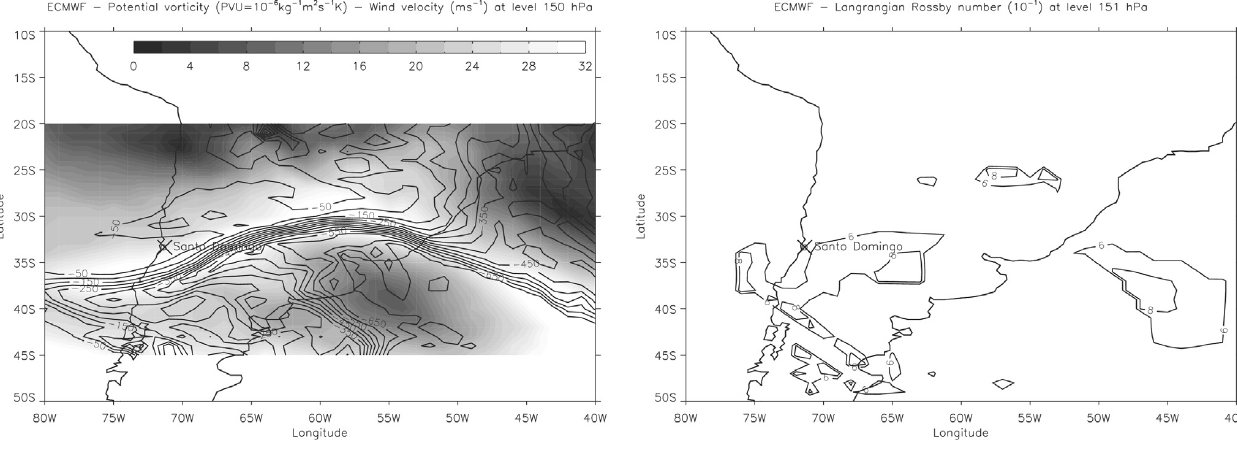
Fig. 4. Case 1: Results of the ECMWF reanalysis at the 150 hPa level (altitude ∼ 11.6km). The Santo Domingo location is marked by the cross. Left: Contours: potential vorticity field (in PVU, 1PVU = 10 − 6 Km 2 kg − 1 s − 1 ). Levels of grey: wind velocity (in ms − 1 ). Right: Lagrangian Rossby number contours. For clarity, only the values of the LR number above the threshold 0.4 and in areas of wind amplitudes exceeding 25ms − 1 are